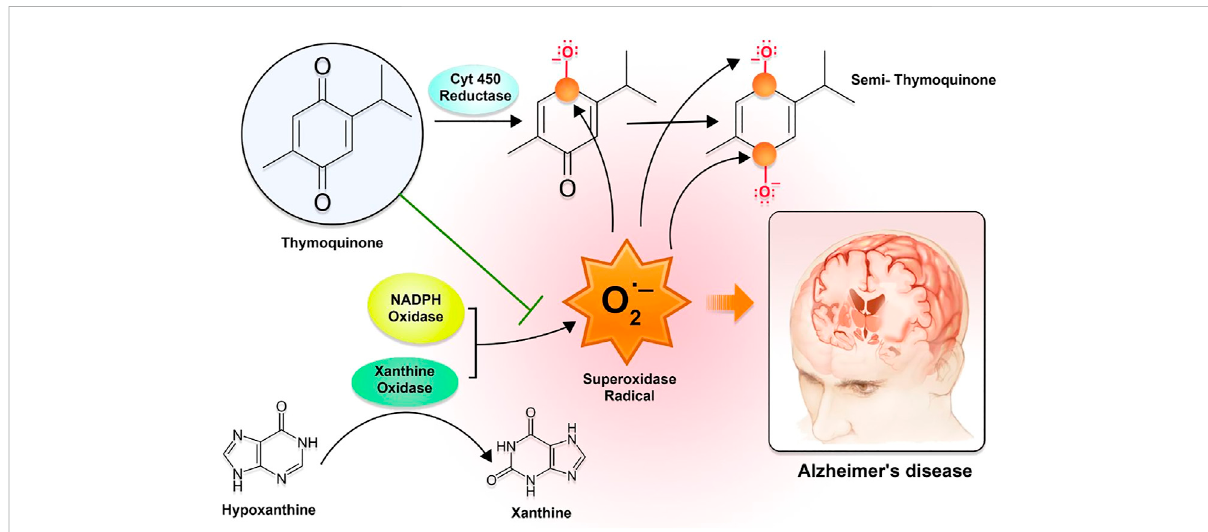
FIGURE 2 Themechanismofactionofthymoquinonewithregardtooxidativestress-mediatedADsymptoms.TheinteractionbetweenTQandPLGAmay have led to a further sluggish release, which may have restricted the amount of TQ that was released. The TQ primarily exerts its effect by inhibiting the enzyme xanthine-oxidase and lowering the production of superoxide radicals. In contrast, the semi-TQ that is produced by cytochrome 450reductaseofferselectron-de fi cientplatformsatthe fi rstandfourthpositions,whichinturnofferselectron-de fi cientcentersforsuperoxide